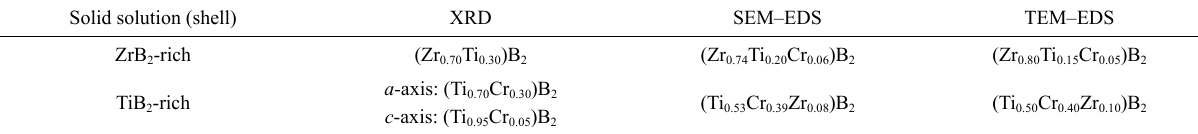
Table 3 Composition of the (Zr,Cr)B 2 solid solutions as measured by XRD, SEM, and TEM–EDS Solid solution (shell)